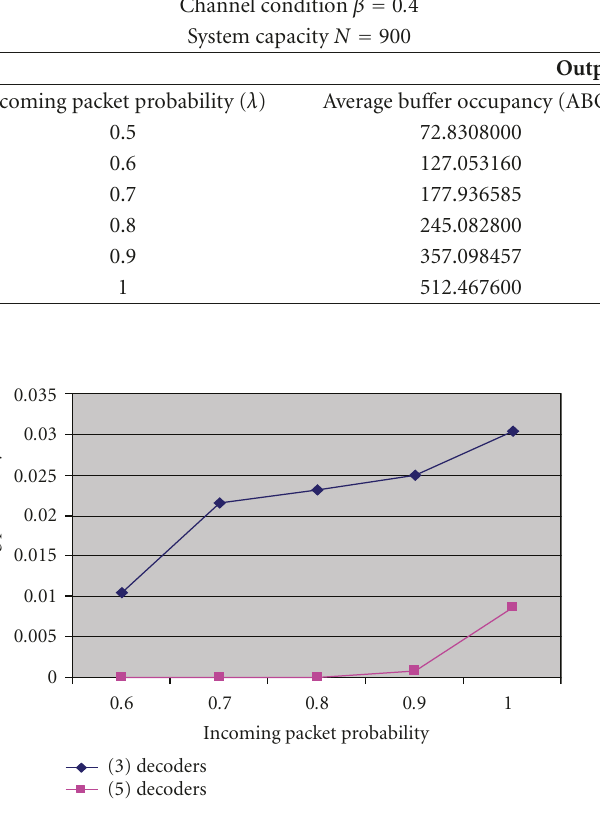
Figure 19: Blocking probability versus incoming packet probability for di ff erent number of sequential